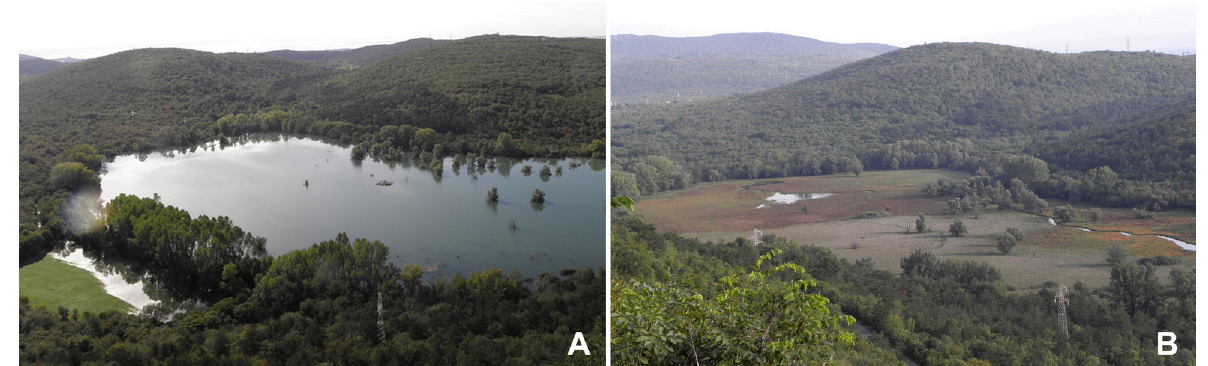
Figure 2. A, Lake Doberdò at seasonal peak of high-water; B, Lake Doberdò at low-water